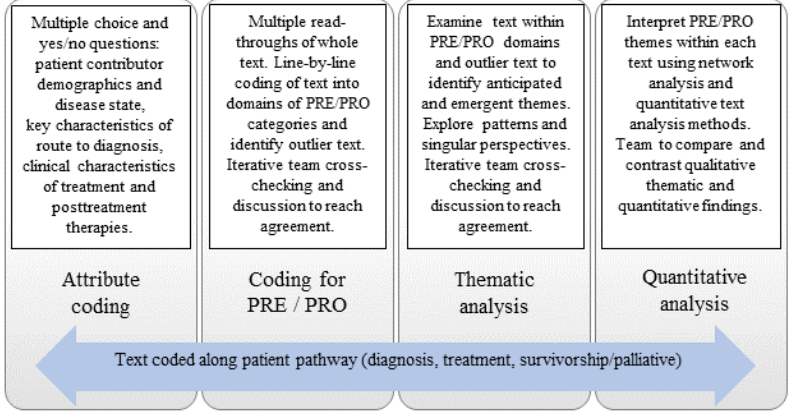
Figure 2. Overview of the framework for analysis. PRE: patient-reported experience; PRO: patient-reported